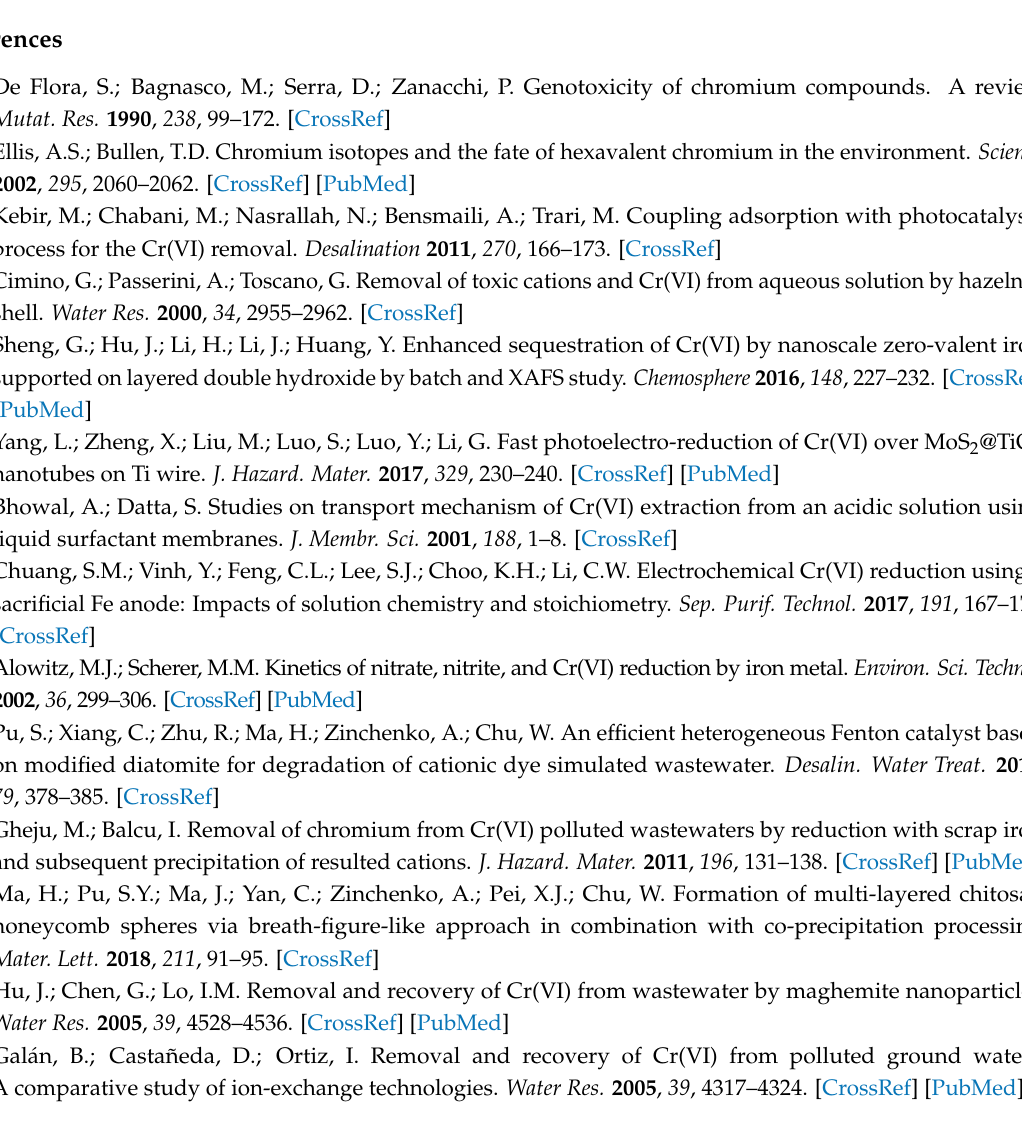
Table S1 BET data for different silver loadings. Table S2 BET data for different solvent concentration. Table S3 Figure S3 Effect of different concentration of empty scavenger (Ethanol) on Cr reduction. Figure S4 Zeta potential of bare TiO 2 and Ag@TiO 2 catalyst. Figure S5 High resolution XPS of Ag 3d of Ag@TiO 2 catalyst before ( a ) and after ( b ) reaction. Figure S6 The survey spectrum XPS spectra of the Ag@TiO 2